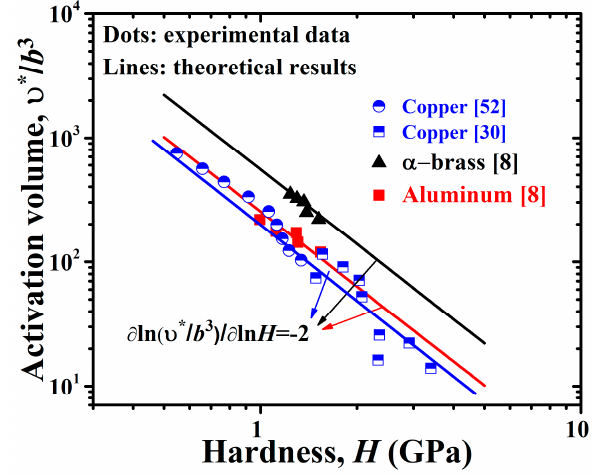
Commented [M3]: Please use scientific notation to replace E in the figure (a) (b) Done!